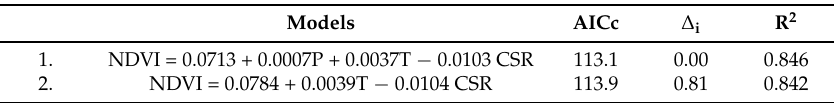
Table 2. Regression coefficients of NDVI models with temperature, precipitation and gravity from 2003 to